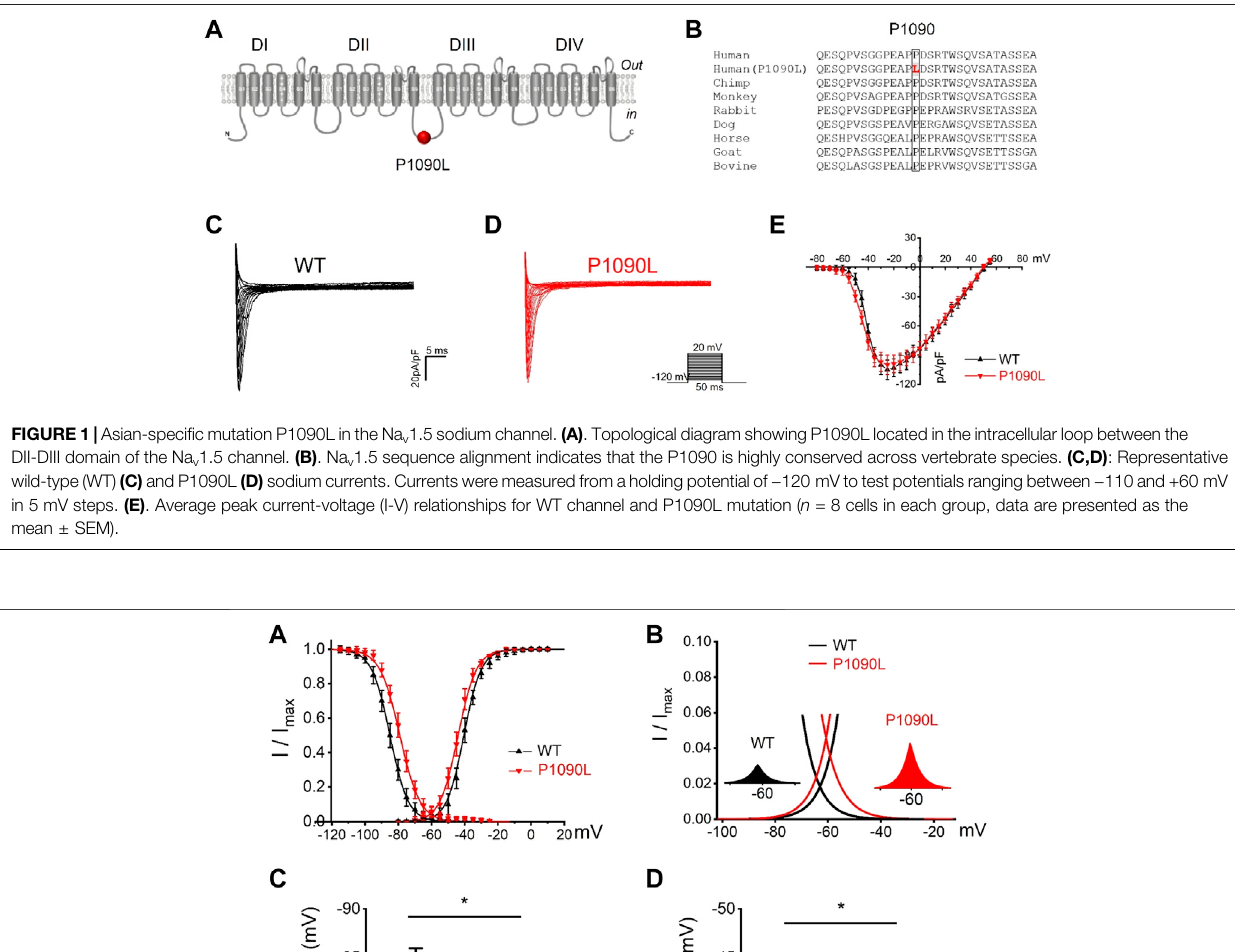
Frontiers in Physiology |